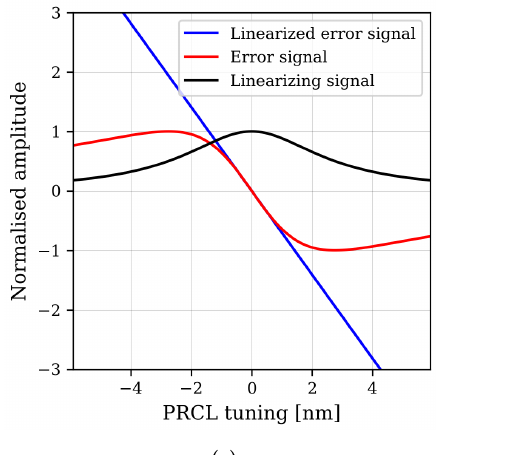
Figure 4. ( a ): Simulated error signal linearization. In red, the PRCL error signal, B2 6MHz. In black, the linearizing signal, magnitude of B4 12MHz. In blue, the PRCL error signal divided by the linearizing signal. ( b ): Experimental comparison, during a free scan of the PRCL DOF, of linearized and non-linearized signals for the control of PRCL in the proximity of the PRC